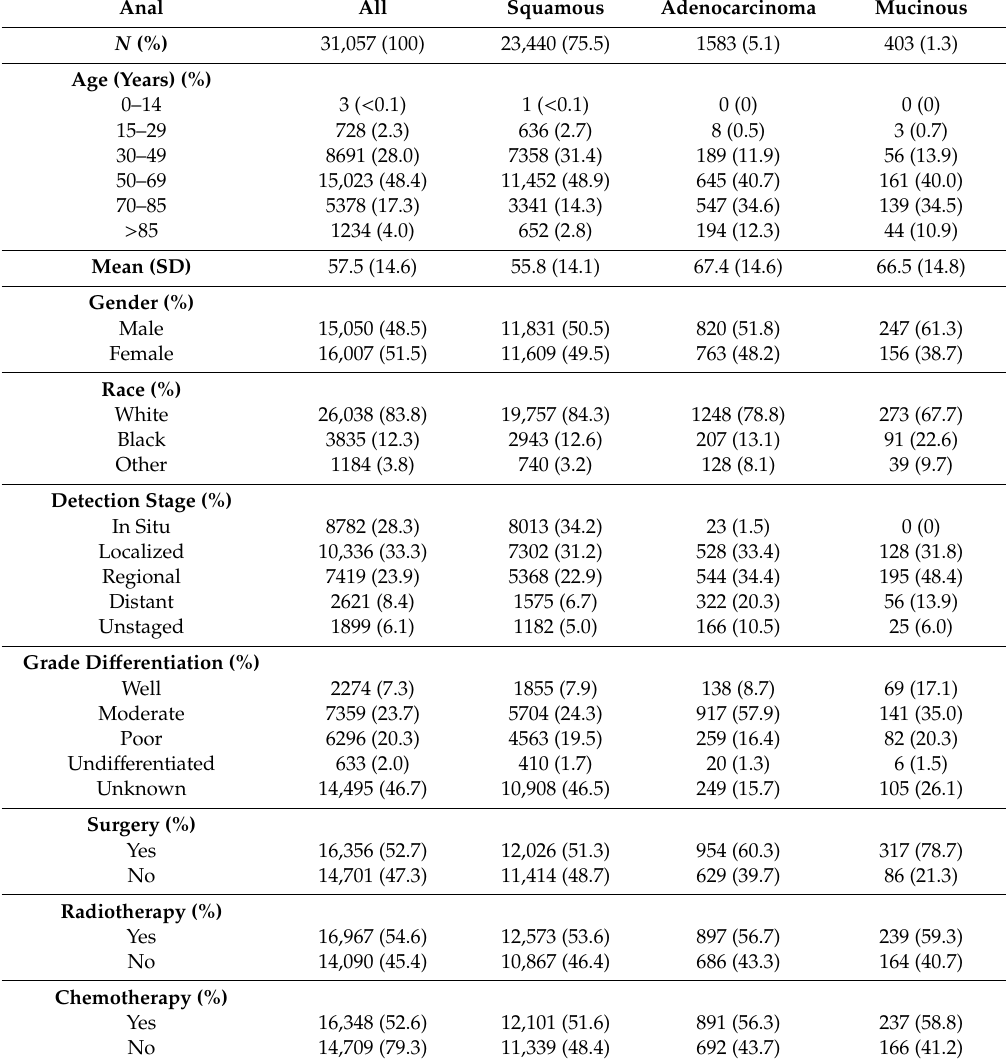
Table 25. Baseline demographics and clinical characteristics by histology for anal